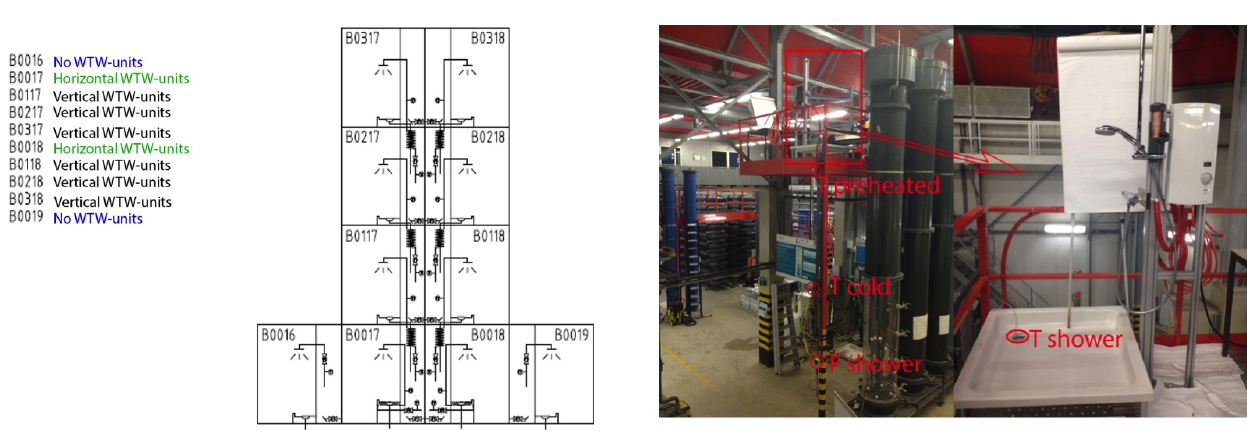
Figure 1. Student apartments monitored.